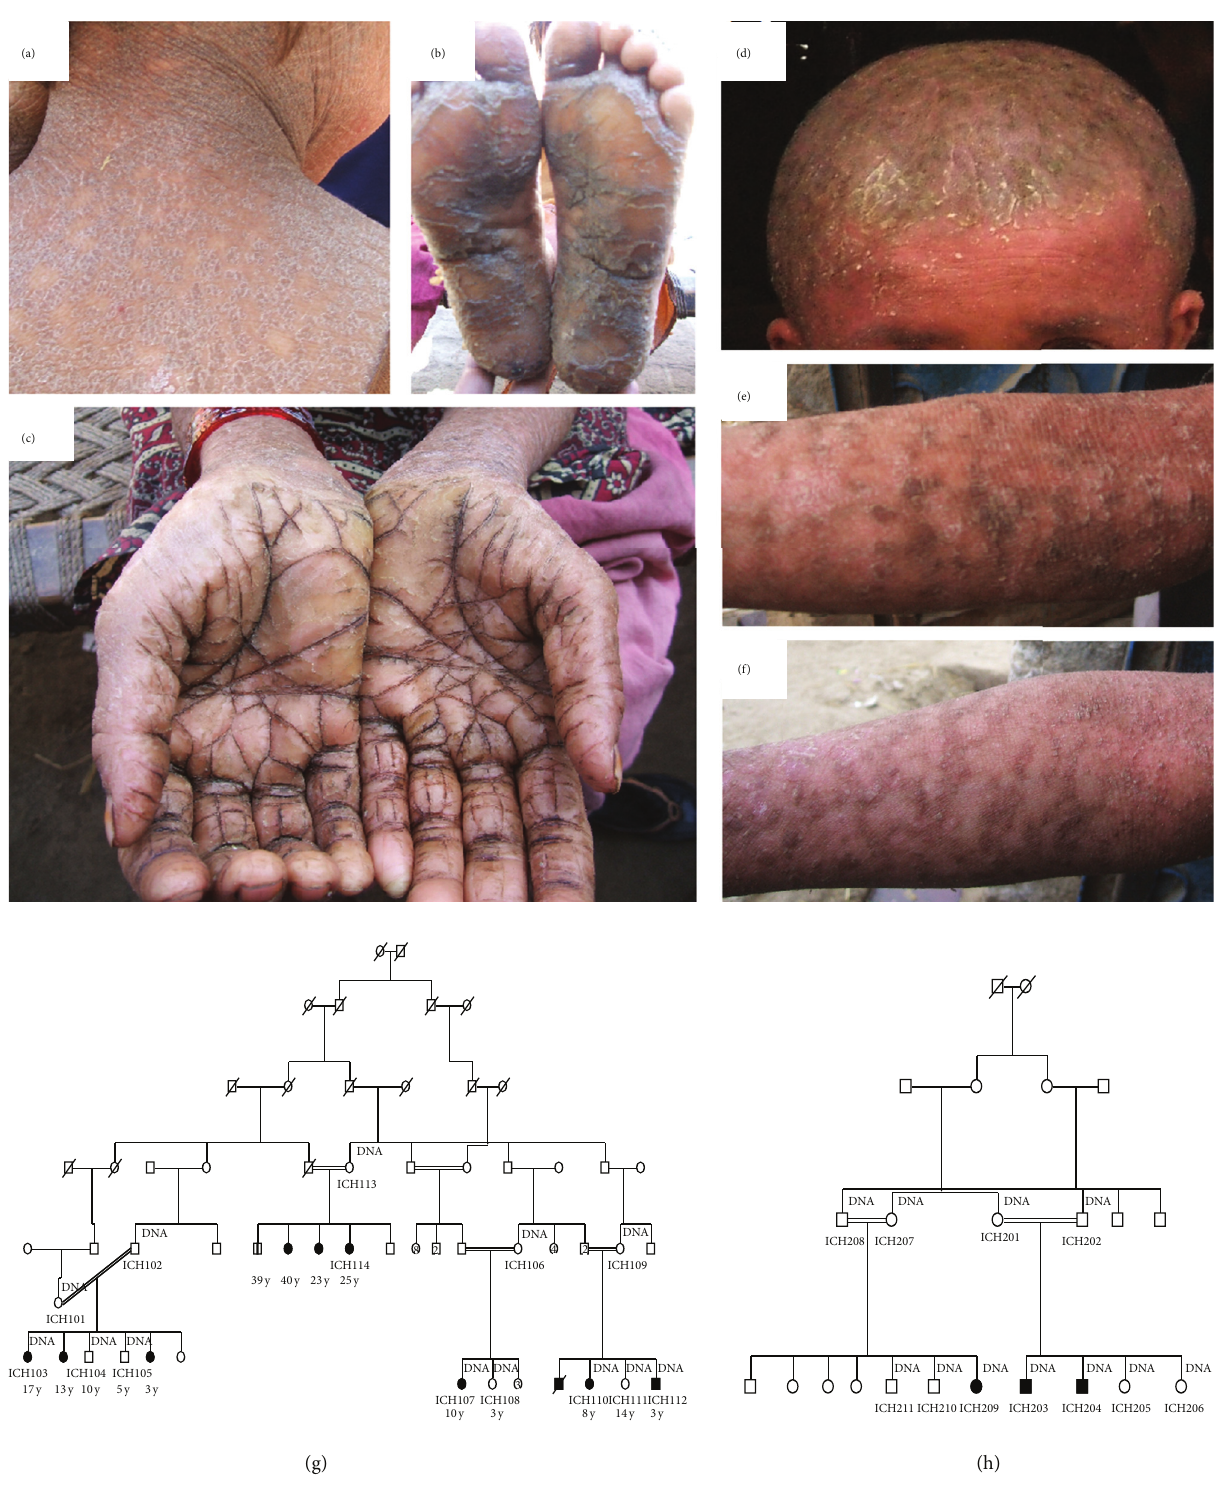
F 1: (a) Clinical features for several patients from family 1 with ichthyosis: proband from family 1 shows dry, cracked skin and hyperkeratosis on the bottom of the feet. (b) Clinical features for several patients from family 1 with ichthyosis: another member of family 1 e�hibits �ne, white scales in addition to erythroderma over entire body. (c) Clinical features for several patients from family 1 with ichthyosis: severe hyperlinear palms on an additional member of family 1. (d) Clinical features for several patients from family 2 with ichthyosis: the patient e�hibits yellowish adherent scales and dry skin on the scalp. In addition, the patient displays �ne white scales over the entire body and erythroderma.(e)and(f)Clinicalfeaturesforseveralpatientsfromfamily2withichthyosis:hyperkeratosiscanbeobservedonthefeet,knees, and elbows (b and c). e patient and the other affected individuals in the family all have hypohidrosis and have severe heat intolerance. e affected patients in family 2 also have difficulty in breathing and allergic rhinitis. (g) Anonymous pedigree information for family 1: members included are labelled by ICH followed by a number. (h) Anonymous pedigree information for family